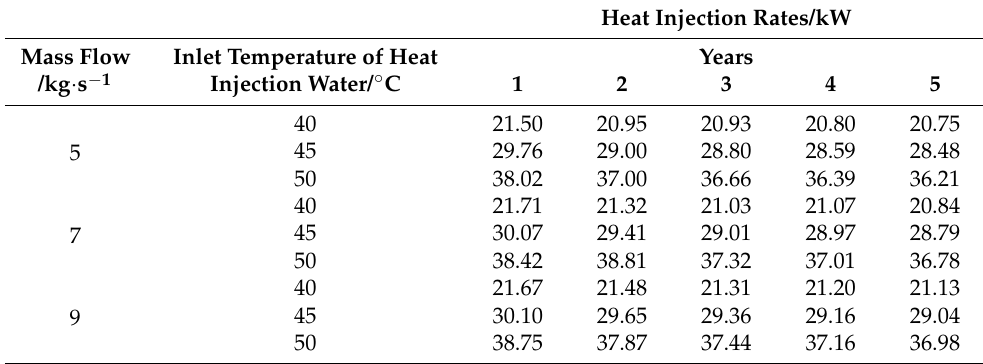
Table 6. Heat injection rates of the novel DBHE system over five